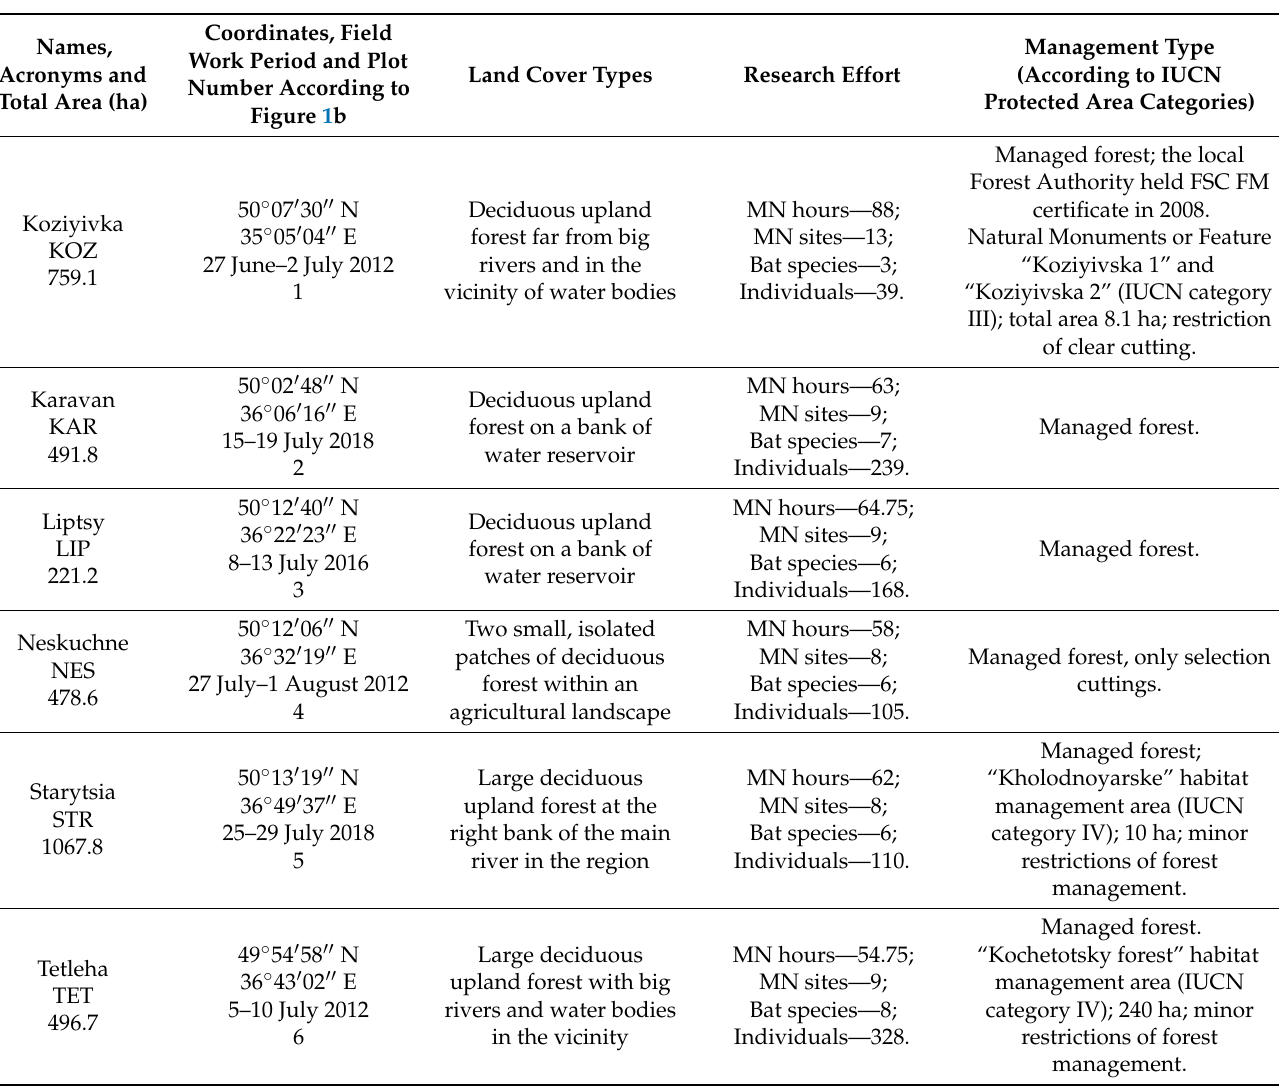
Table 1. Characteristics of the study plots and research efforts (MN hours—total mist-netting hours; MN points—number of mist-netting sites; Individuals—total number of caught